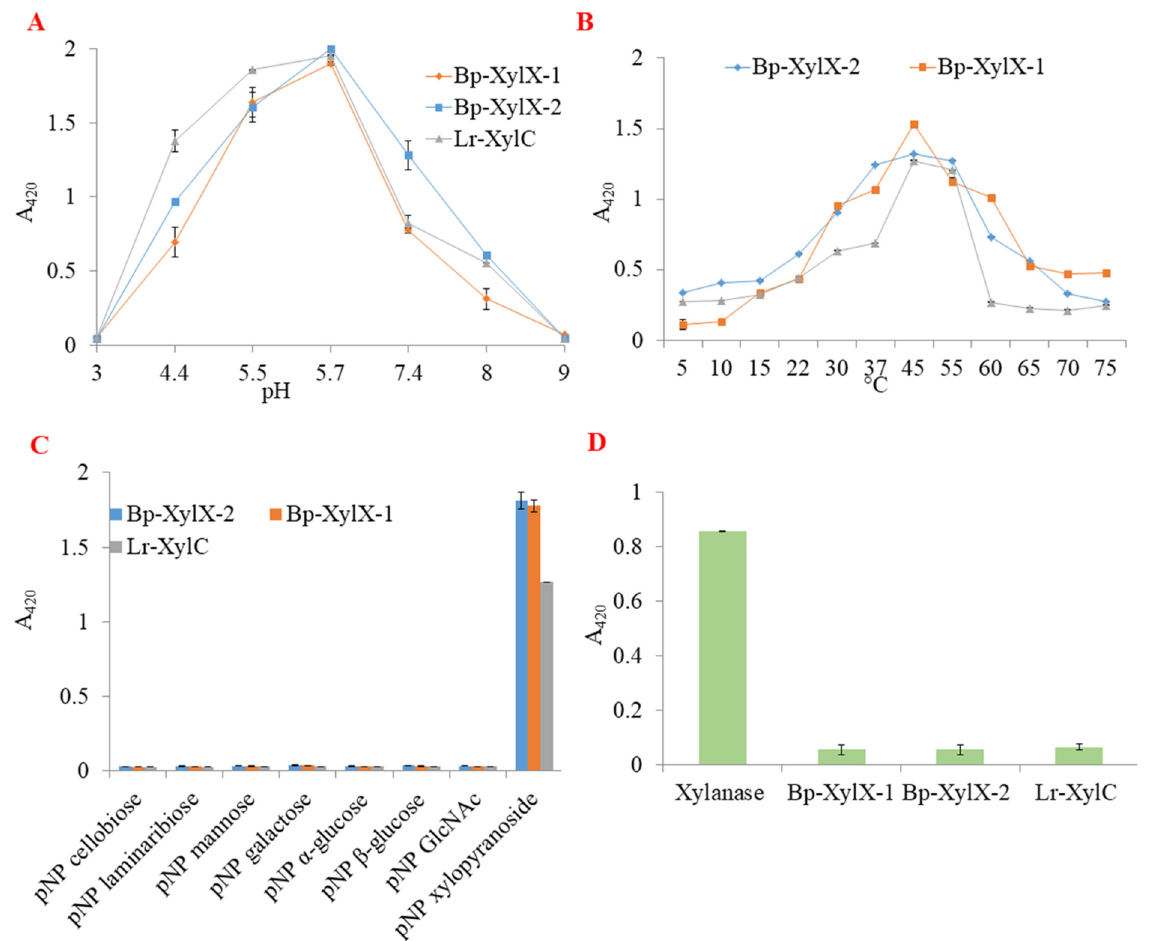
Figure 3. Characterisation of Bp-XylX-1, Bp-XylX-2, and Lr-XylC β -xylosidase enzymatic activity. The optimum ( A ) pH and ( B ) temperature of recombinant β -xylosidases were determined using p NP-Xyl (2 mM final concentration) in different buffers and temperatures. ( C ) The enzymatic activity of recombinant β -xylosidases was determined on artificial substrates at 2 mM final concentration. ( D ) Assessment of endolytic activity was performed with K-Xly 6- p NP (2 mM final concentration) where a commercial xylanase was used as control.